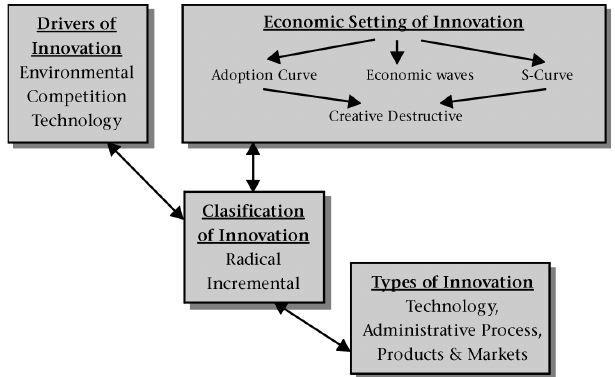
Figure 2: Contextual environment and approaches to